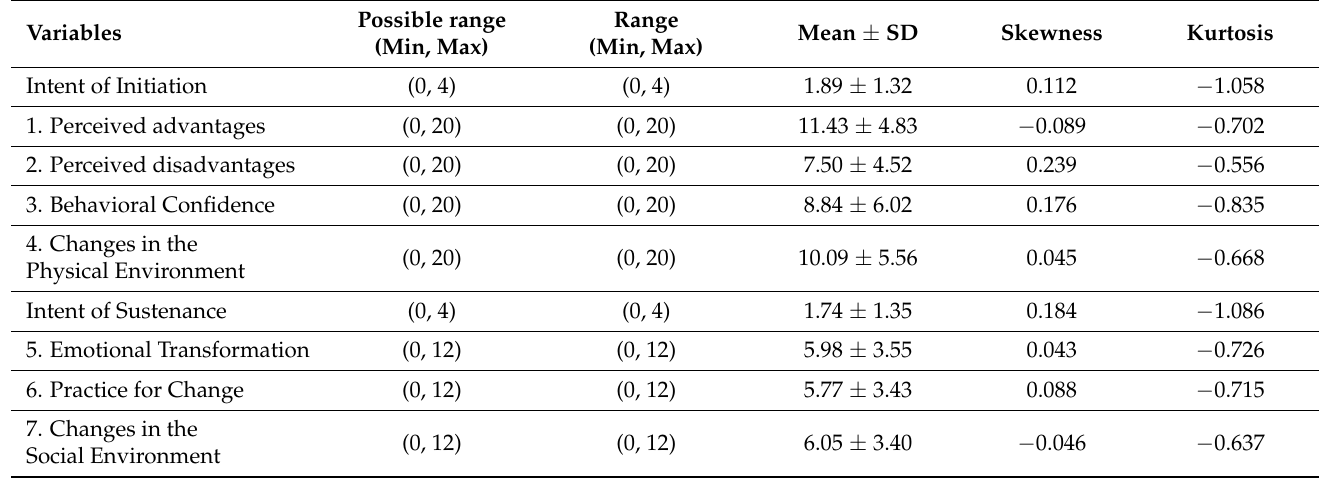
Table 4. Mean score and ranges of MTM